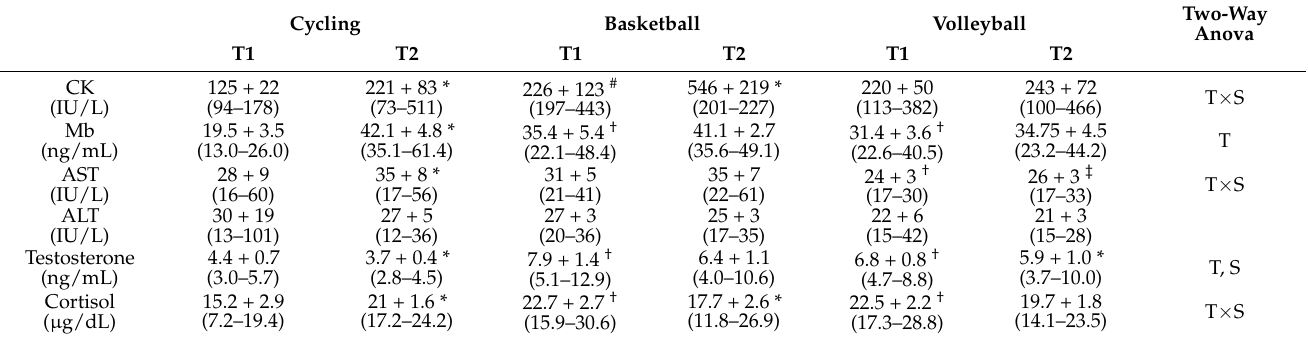
Table 3. Quantitative analysis of the changes observed in muscular damage blood markers in cyclists, basketball, and volleyball players at the end of T1 and at the end of